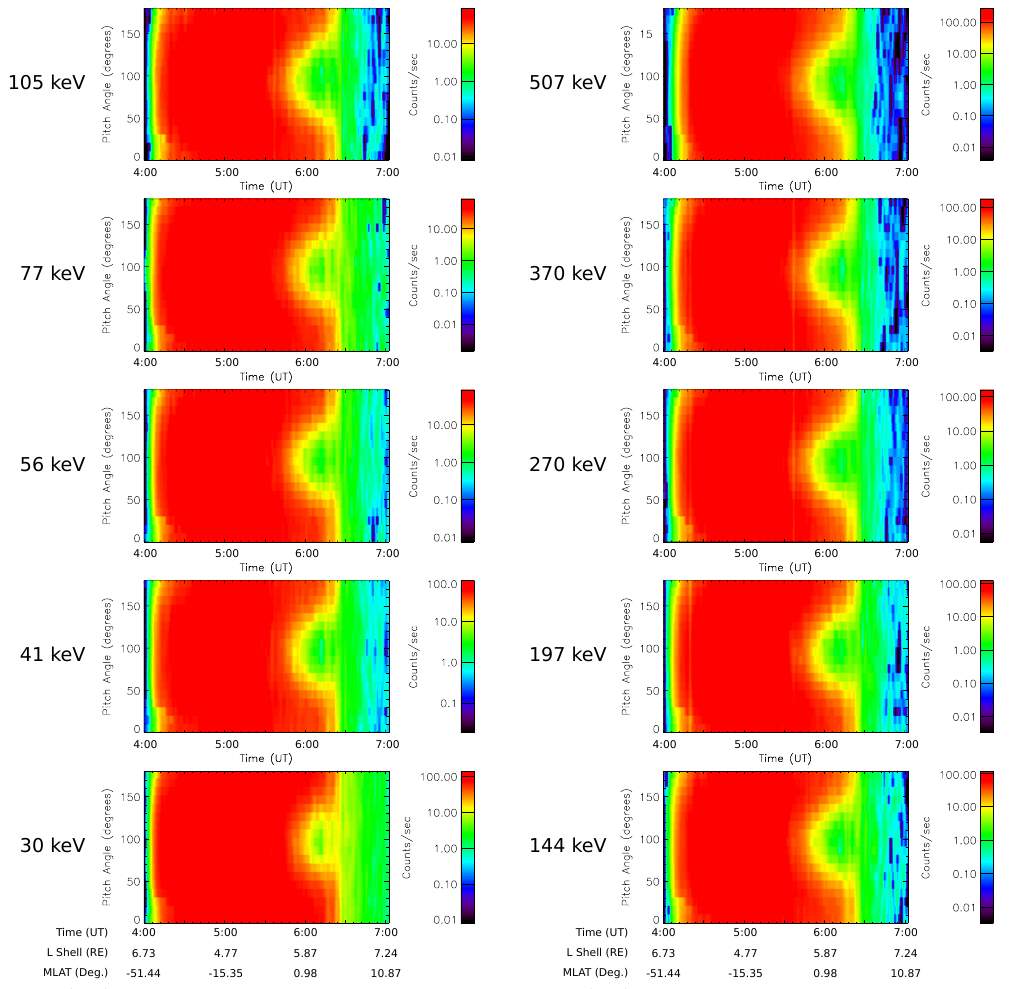
Fig. 3. Electron flux plots from the IES sensor for ten energy channels (indicated by the nominal energy threshold to the left) on Polar for 12 September 2000, with electron flux plotted as functions of pitch angle and time. Butterfly PADs occur between 05:30UT and 06:30UT with a bowl-like